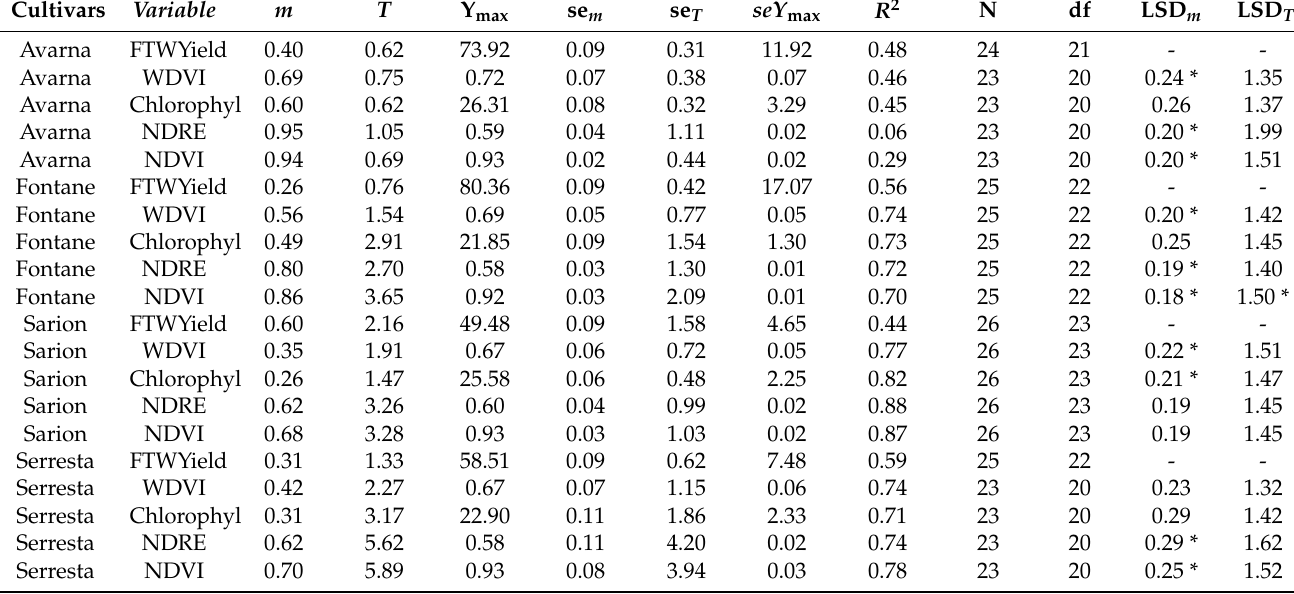
Table 4 shows the output parameters of the relationship between P i and UAV indices: weighted difference vegetation (WDVI), red-edge chlorophyll index (chlorophyll), normal- ized difference in red edge (NDRE), and normalized difference vegetation index (NDVI) of the four potato cultivars compared to the output parameters of the fresh tuber yield by using Equation (1). As can be seen in Table 4 of the relationship between P i and UAV indices, ( P i~WDVI and P i~Chlorophyll content index) are similar. The same holds true for the relationship between ( P i~NDRE and P i~NDVI), which are also similar. Therefore, we prefer to show the relationship between P i and WDVI in Figure 5 and the relationship between P i and NDVI in Figure 6. The relationship between P i~NDRE and P i~Chlorophyll is provided in the Supplementary Figures S3 and S4. As can be seen in Table 4, comparisons were performed between the output parameters (relative minimum UAV values and the tol- erance limit) of the UAV indices and that of the fresh tuber yield per cultivar. The minimum UAV indices of all the variables, except the relative minimum chlorophyll content indices, were significantly different from that of the relative minimum fresh tuber yield. Only in one case of the cv. Sarion, the chlorophyll content index observed was significantly different. Similarly, except in the cv. Sarion (chlorophyll content index), in all other cultivars, the relative minimum UAV value of the indices increased significantly as compared to that of the relative minimum value of the fresh tuber yield. Table 4. The output parameter values according to (Equation (1)) describing the relationship be- tween P i and UAV indices: weighted difference vegetation (WDVI), red-edge chlorophyll index (chlorophyll), normalized difference in red edge (NDRE), normalized difference vegetation index (NDVI), and fresh tuber yield of four potato cultivars: Avarna, Fontane, Sarion, and Seresta, where m = relative minimum value of the measured UAV indices; T = tolerance limit in eggs (g dry soil) − 1 ; Y max = maximum value of the measured UAV indices when P i = 0 eggs (g dry soil) − 1 ; se m = standard error of relative minimum UAV indices; se T = standard error of tolerance limit; se Y max = standard error of the maximum value of the measured indices; R 2 = coefficient of determination; df = degrees of freedom. LSD = least significant difference. * Significantly different parameter values of UAV indices compared to the parameter values of the fresh tuber yield at 5% level of